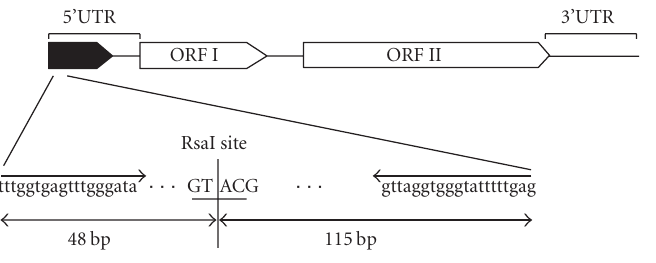
Figure 1: Genomic structure of LINE-1 in rats. Total length is 6kb which is composed of three portions, 5’ UTR, ORF I, ORF II, and 3’UTR. Bisulfite PCR was conducted in the 5’UTR sequence. The primer sequences are shown with arrows. DNA cytosine methylation. Therefore, it is possible to